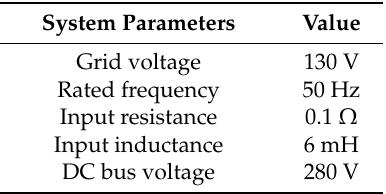
Table 1. Parameters of VSG system.